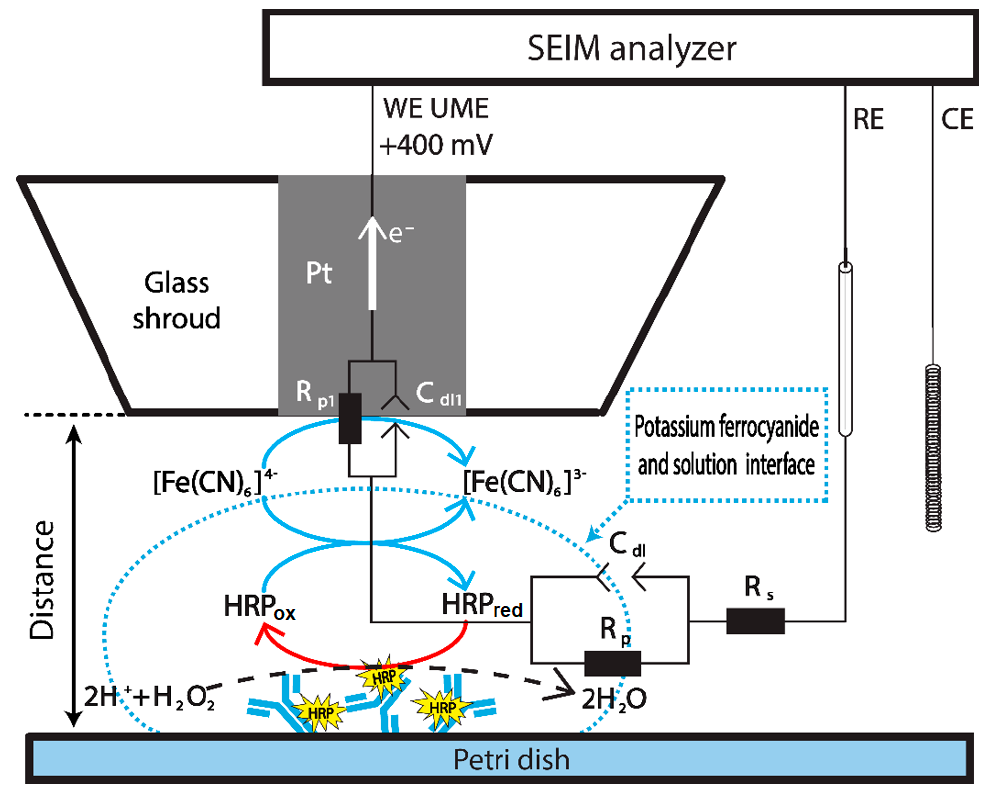
Figure 1. Schematic representation of Ab-HRP detection by EIS in the presence of potassium ferrocyanide (K 4 [Fe(CN) 6 ]), which serves as a redox mediator. HRP ox/red —oxidized and reduced forms of horseradish peroxidase.